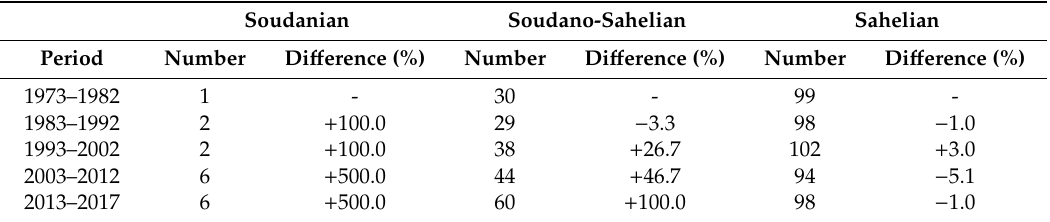
Figure 2. Mean annual maximum temperature (Tmax), lineal regression, and statistical significance along the different agroclimatic zones (Soudanian, Soudano-Sahelian, and Sahelian) for the period 1973–2017. Table 3. Changes in the number of days per year with temperatures above 40 ◦ C along the di ff erent agroclimatic zones (Soudanian, Soudano-Sahelian, and Sahelian) for the period 1973–2017.